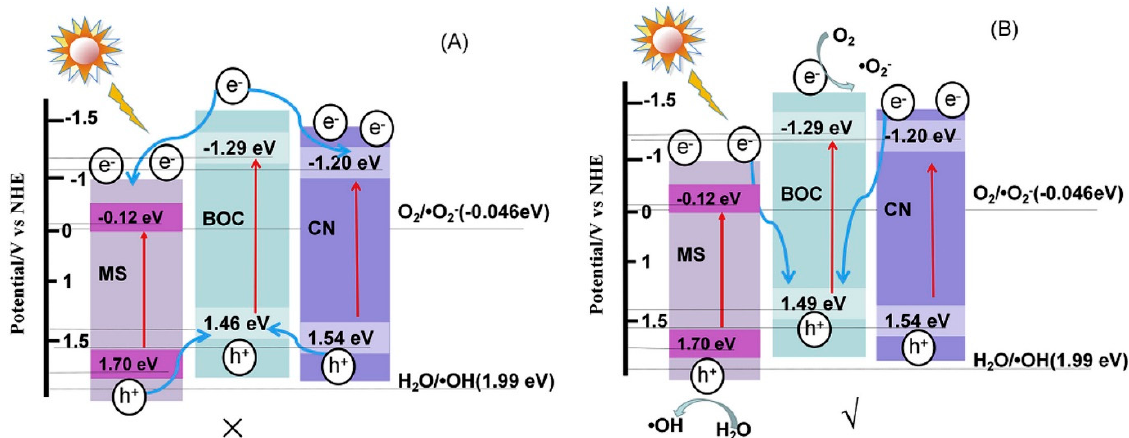
Figure 14. Schematic representation of the possible steps involved during the photocatalytic process and the charge transfer mechanism in the g-C 3 N 4 /MoS 2 /Bi 24 O 31 Cl 10 composite: ( A ) traditional pathway and ( B ) dual Z-scheme pathway. Reprinted from Ref. [155] with permission from Elsevier.